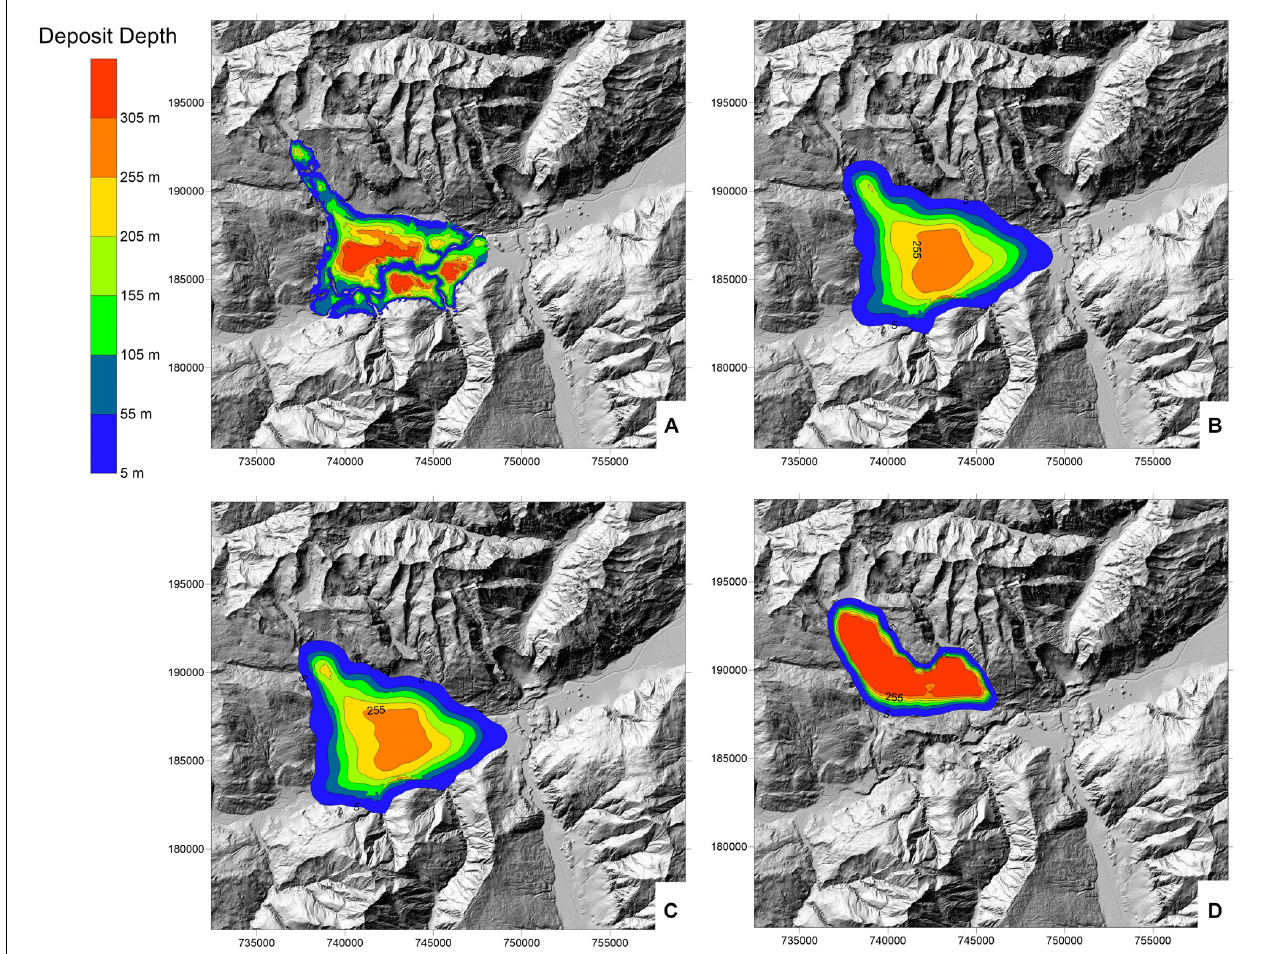
FIGURE 13 | Dan3D results for the three scenarios. (A) Reconstructed deposit depth. (B) Two-rheology simulation. (C) One-rheology simulation. (D) Simulation assuming only cohesion loss along the rupture plane